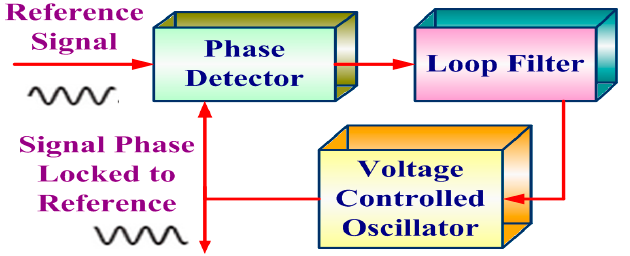
Figure 4. Basic Phase Locked Loop (PLL) Structure.